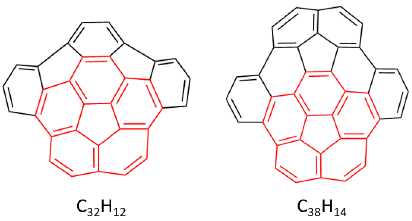
Figure 20. Chemical structure of corannulene-based C 32 H 12 and C 38 H 14 buckybowls. The corannulene skeleton is highlighted in red.